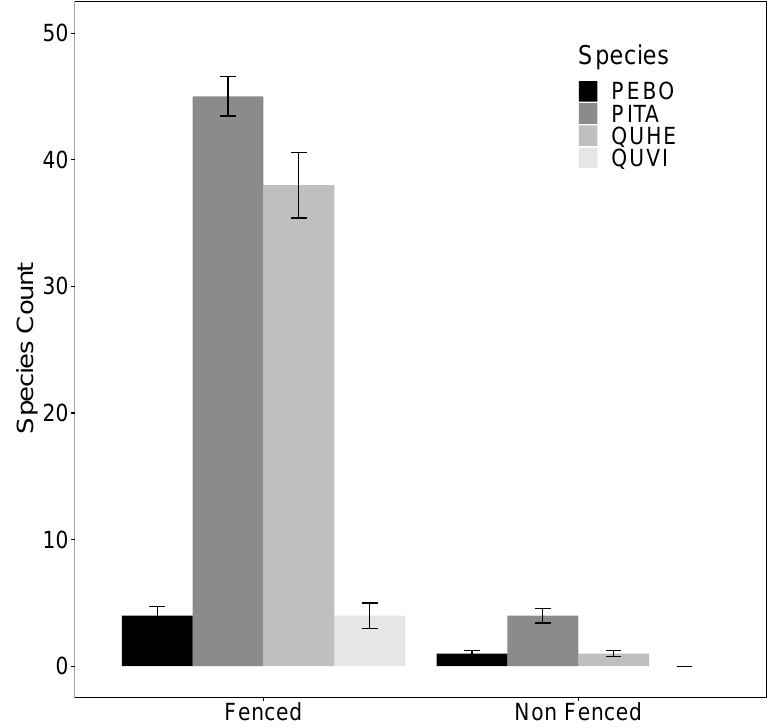
Figure 4. Total number of natural regenerating individuals of each tree species in non-weeded subplots within fenced and non-fenced plots in 2018 after three growing seasons. PEBO = Persea borbonia (red bay). PITA = Pinus taeda (loblolly pine). QUHE = Quercus hemisphaerica (laurel oak). QUVI = Quercus virginiana (live oak).